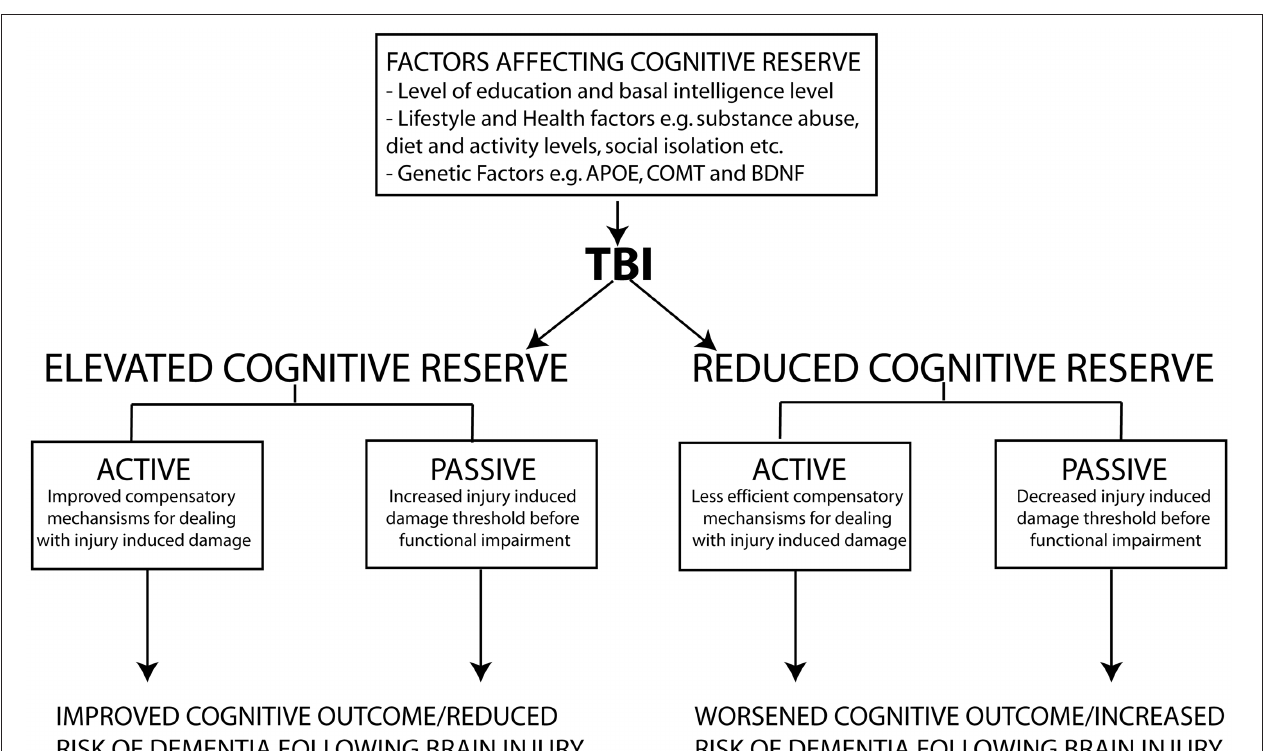
FIGURE 5 | Cognitive reserve as a risk modifier for cognitive dysfunction and dementia following TBI. A number of environmental and genetic factors determine a persons level of cognitive reserve, those individuals with higher cognitive reserve are predicted to have a better cognitive outcome and a reduced risk of developing dementia following